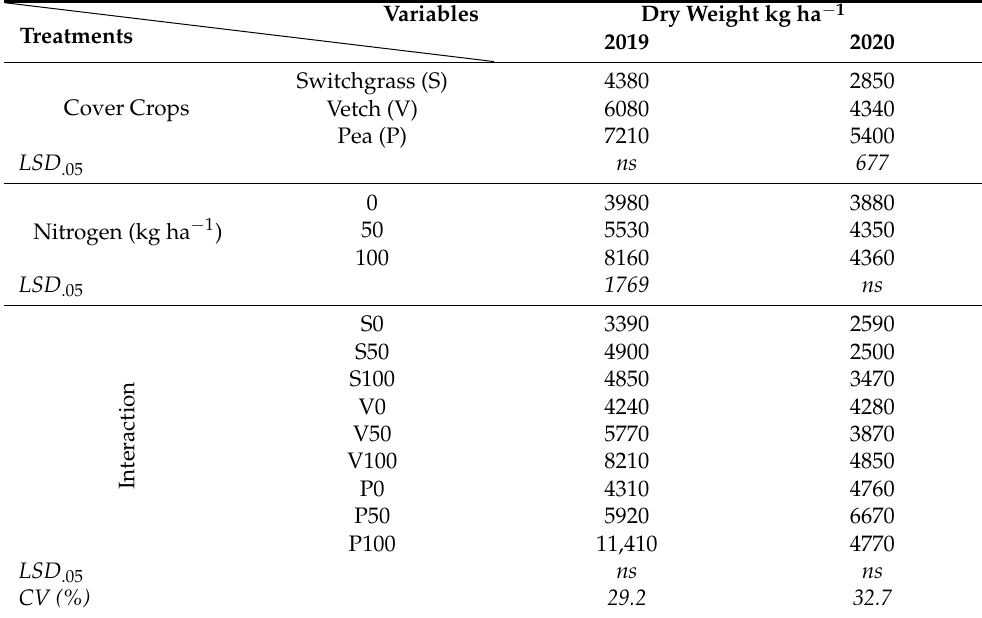
Table 3. Dry yield at the second harvest (October cutting) in switchgrass cultivation derived from a monoculture and mixed culture with vetch or pea under different N application rates during the cultivation years 2019 and 2020.